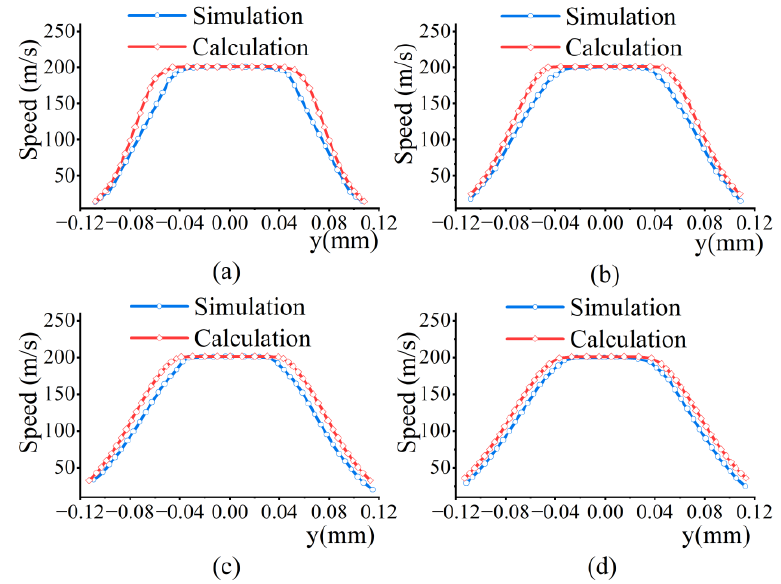
Figure 16. Comparisons of velocity distributions in deflector. ( a ) x = 0.147 mm. ( b ) x = 0.245 mm. ( c ) x = 0.413 mm. ( d ) x = 0.485 mm.